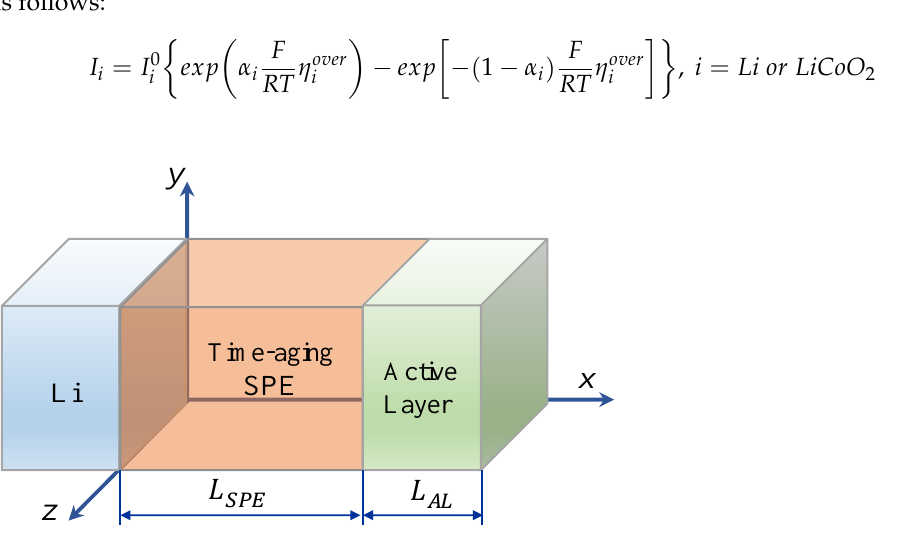
interface and the transports of cations and anions under the electric field in SPE and LiCoO 2 .